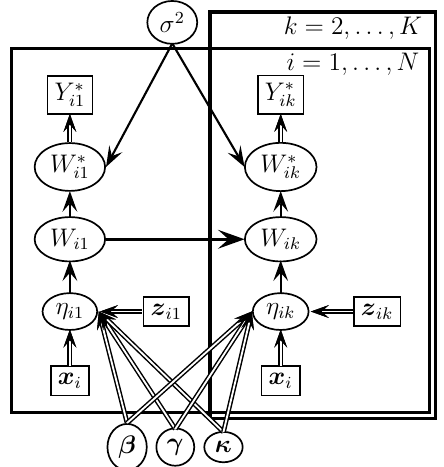
Figure 2. Flowchart for the proposed model. It represents a direct acyclic graph, where the nodes are the model variables and the arrows show dependencies between them. There are two rectangular frames representing sets of identical repeating operations. Square boxes represent observed variables, and ovals represent latent variables and unknown